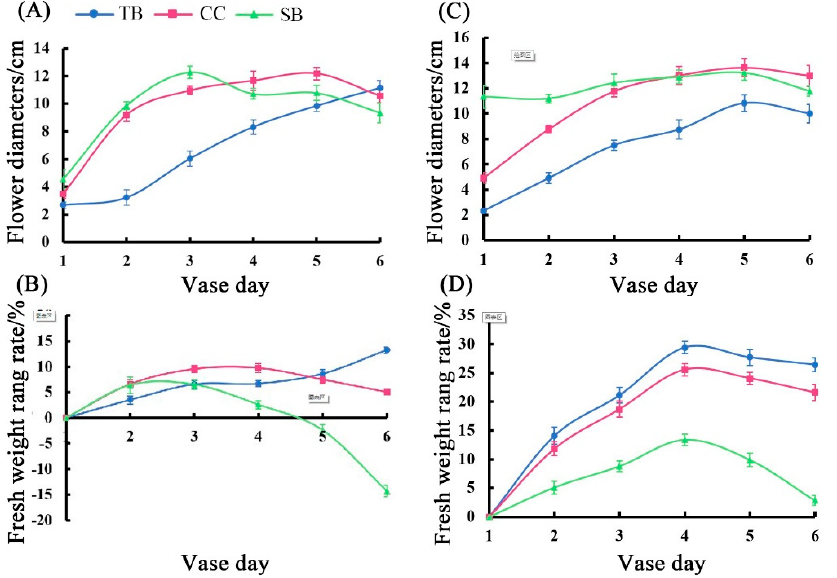
Figure 4. Physiological characteristics of in different harvest stages of “unfold-petal type” cut P. lactiflora . ( A , C ) Flower diameter change and fresh weight change rate of ‘Qihua Lushuang’ in three harvesting stages during bottling. ( B , D ) Flower diameter change and fresh weight change rate of ‘Lian Tai’ in three harvesting stages during bottling. TB, tight-bud; CC, changing-color; SB, soft-bud. Values are expressed as the mean ±SD of three analyses. The vertical bar represents the standard deviation of the mean .